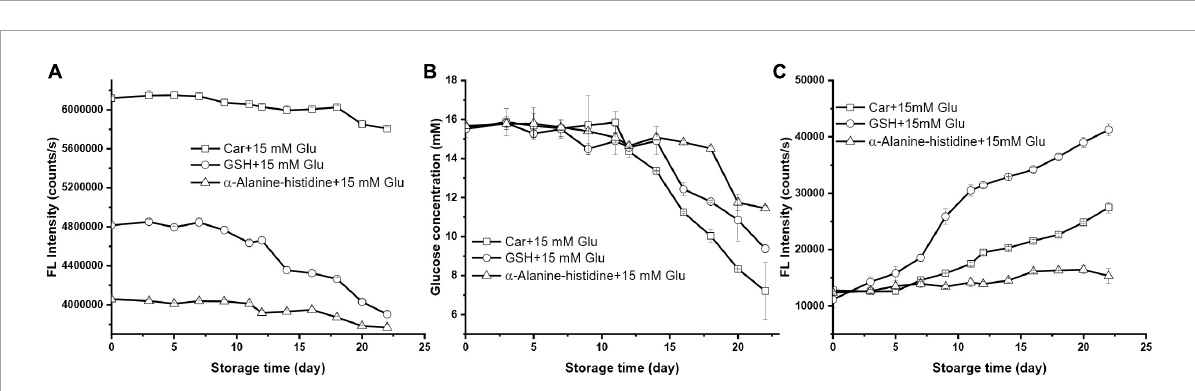
FIGURE4 The changes of (A) GSH florescence intensity, (B) glucose concentration, and (C) the formation of MRP during storage (the initial mixture contained 10 mM carnosine, GSH, alpha-alanine-histidine with 15 mM